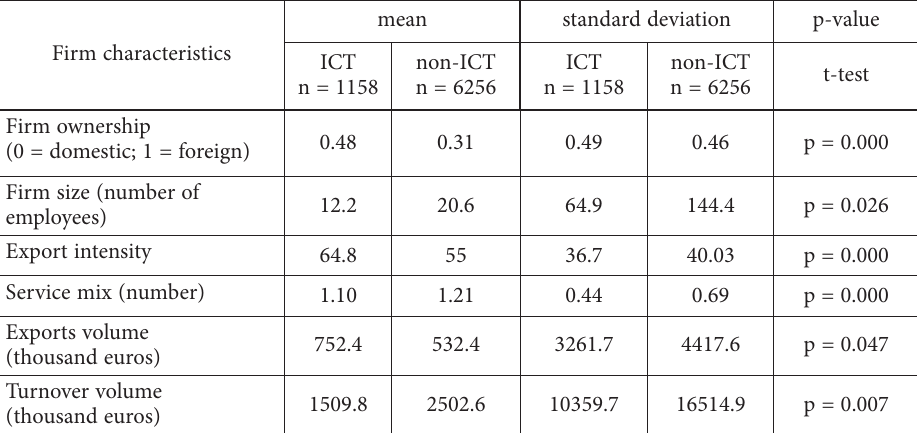
Table 2. Comparison of the means of ICT and non-ICT groups in Estonia, 2018 (source: Statistics Estonia, 2022)